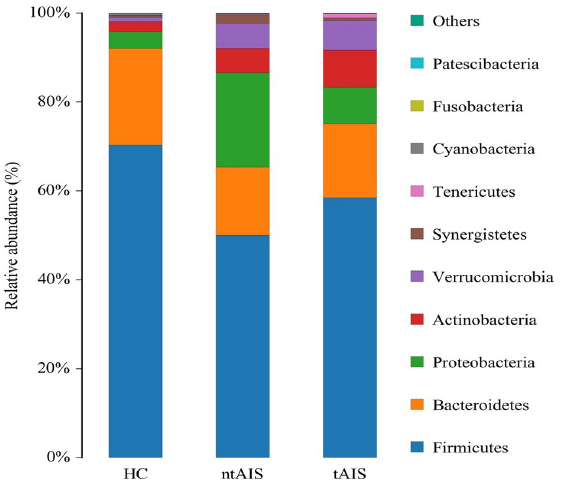
Fig 4. The relative taxa abundance among the three groups at the phylum level. AIS: Acute ischemic stroke; tAIS: Patients with PHS; ntAIS: Patients with non-PHS; HC: Healthy controls. The relative species abundances were calculated as percentages of the total species abundances(the number of tags measured in the sample divided by the total number of tags).